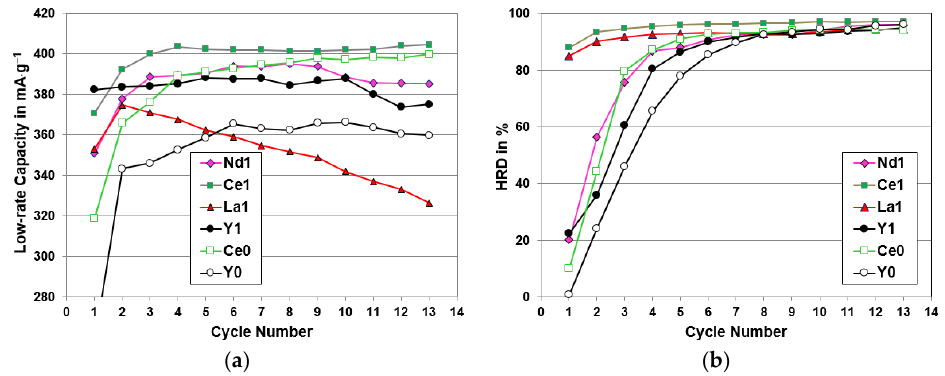
Figure 10. Comparisons of the activation behaviors in ( a ) capacity and ( b ) high-rate dischargeability (HRD) among the RE-free alloys (alloys Y0 and Ce) and 1 at% RE-containing alloys (alloys Y1, La1, Ce1, and Nd1). Table 6. Summary of electrochemical half-cell and magnetic measurements, including the capacities at the third cycle, HRD at the third cycle, number of cycles needed to achieve 92% HRD, bulk diffusion coefficient, surface exchange current, results from AC impedance measurements, saturated magnetic susceptibility, and applied field at half of the saturated magnetic susceptibility.